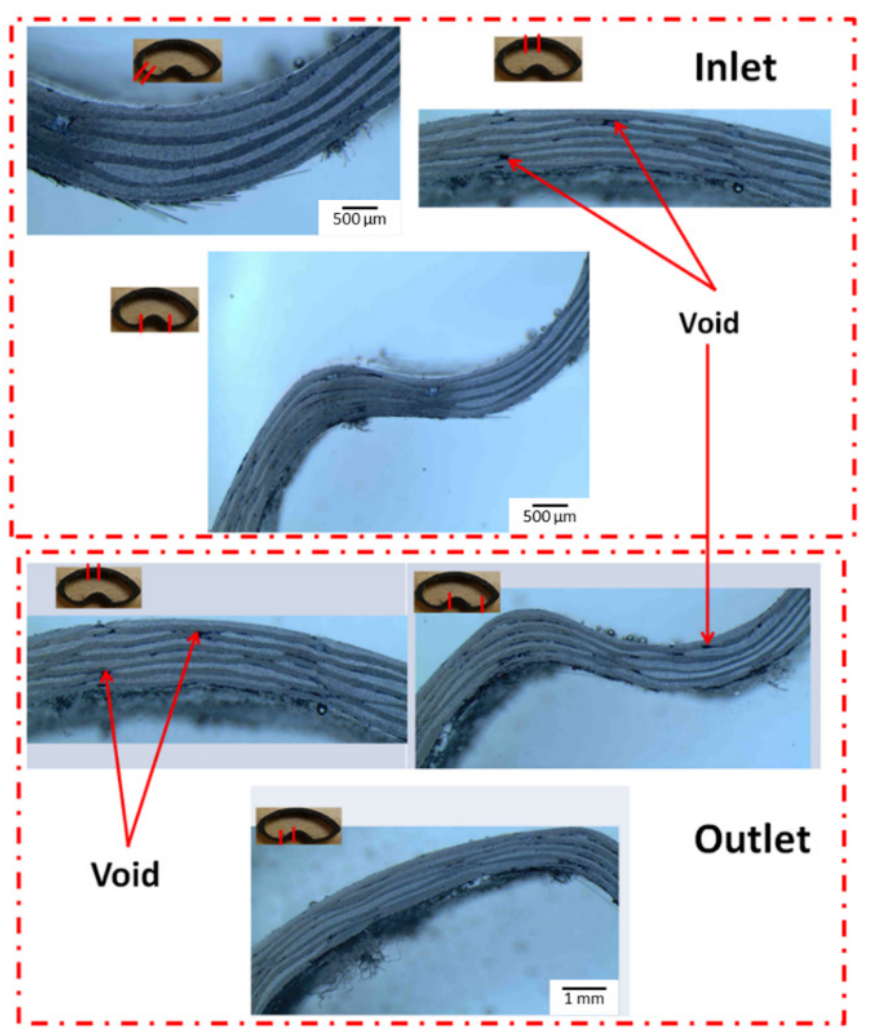
Figure 13. Microscopic images of the tubular section (Test 6) showing minimal void sites at multiple locations of the inlet and outlet sections.